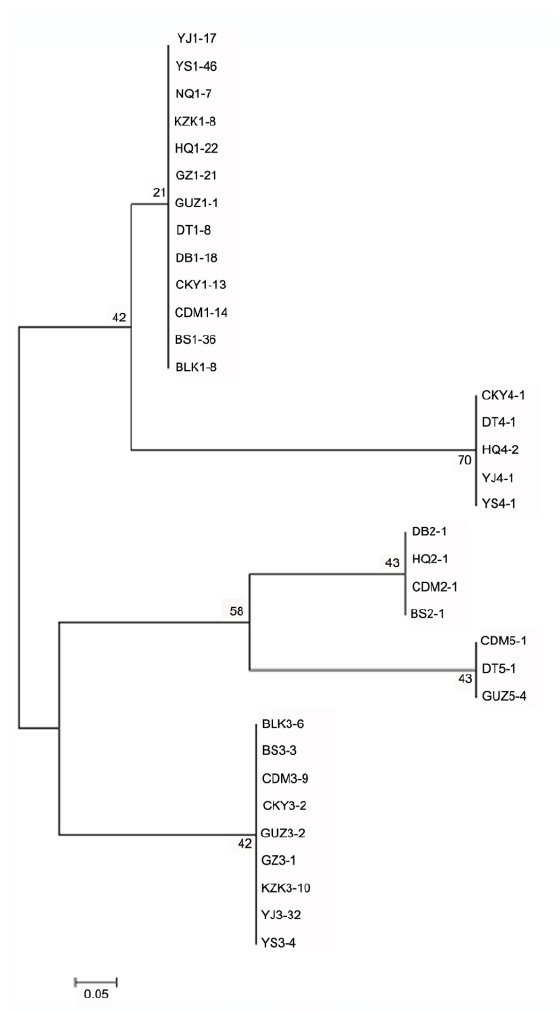
Figure 2. Neighbor-joining tree among 13 horse breeds based on five haplotypes. The number before dash is the haplotype they belong to, the number after dash is the number of individuals.